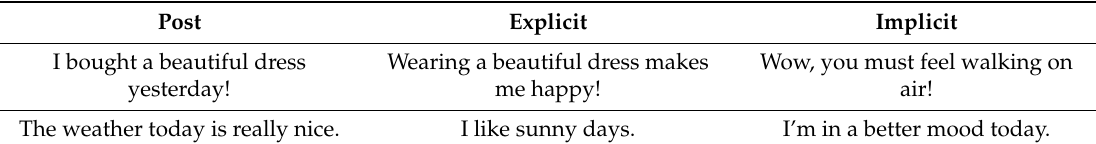
Table 1. Two (explicit and implicit) varieties of emotional